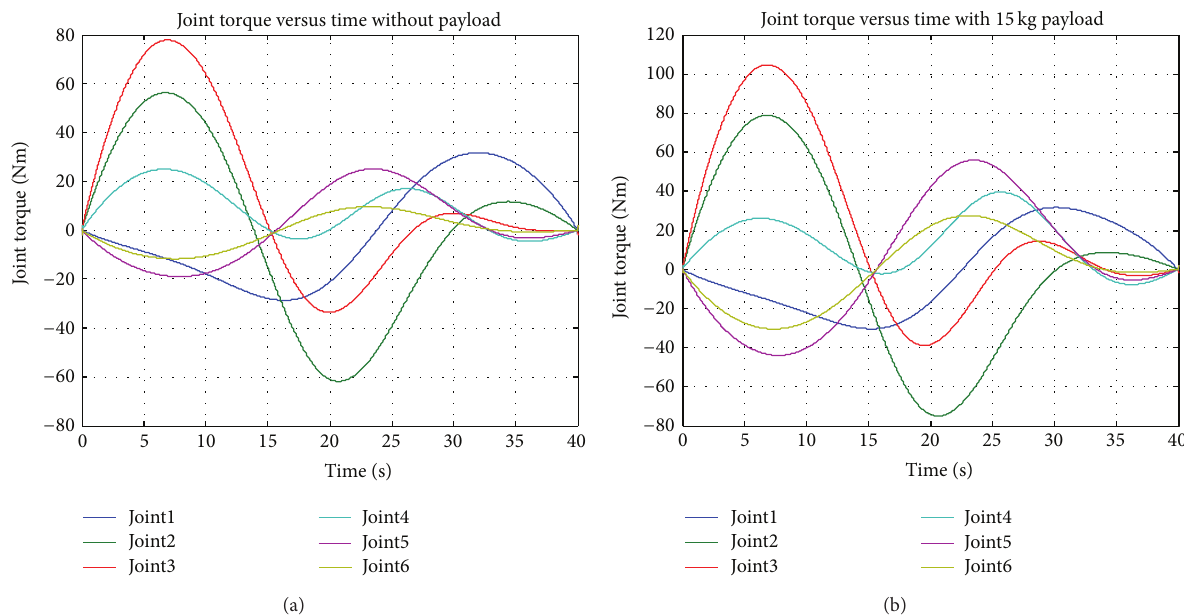
Figure 11: Comparison of torque evolution under no payload (a) and with 15kg payload